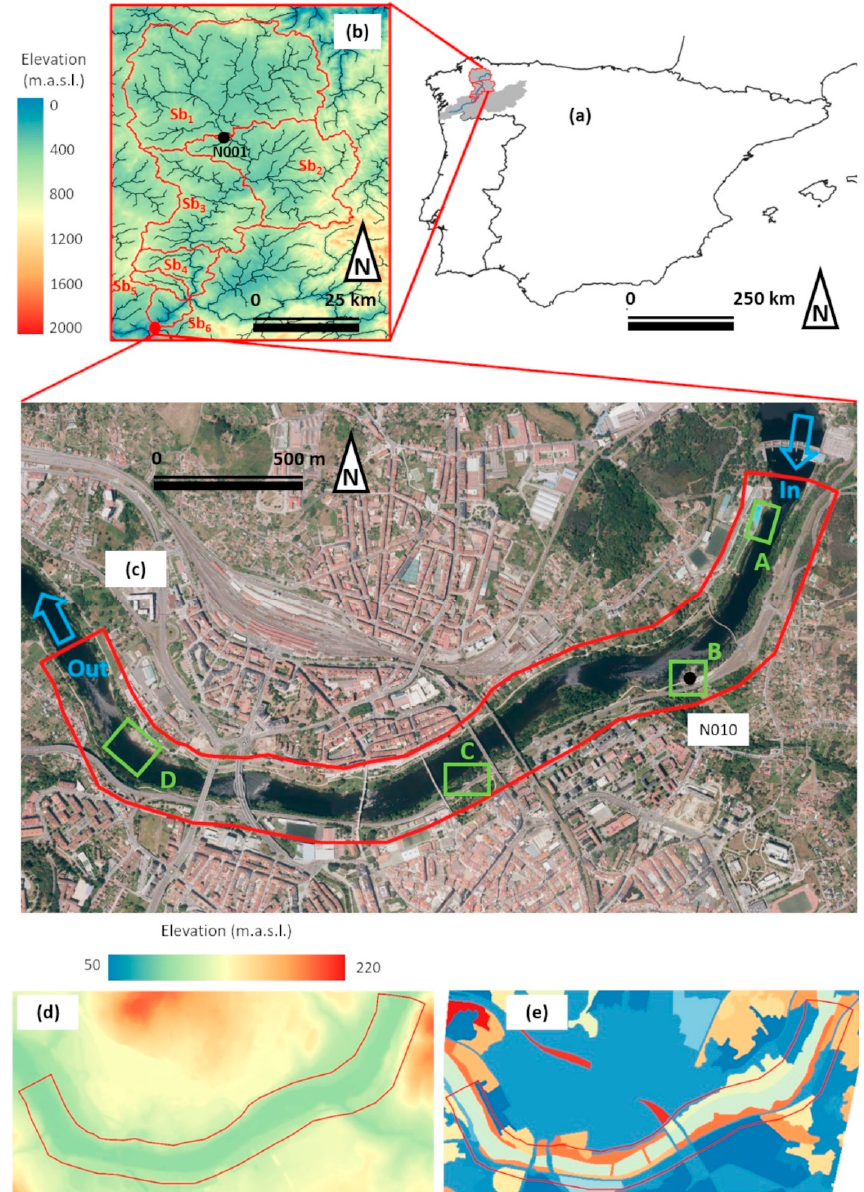
Figure 1. Area of study. ( a ) location of the entire catchment of the shared Portuguese–Spanish Miño River (shaded area) in the Iberian Peninsula and the riverbed (blue line); ( b ) subbasins (Sb1, Sb2, …, Sb6) of the domain; ( c ) area of study in Ourense (PNOA courtesy of © Instituto Geográfico Nacional). Area enclosed by the red line defines the domain of the hydraulic model. The inlet and outlet boundaries of the domain and the gauge stations N001 (Lugo) and N010 (Ourense) are also shown. Green rectangles define the control areas. Control area A: public sport facility; control area B: gauge station N010; control area C: public path; control area D: public thermal baths. The inlet (in blue arrow) and outlet (out blue arrow) boundaries are also depicted. ( d ) Topographic features and ( e ) land uses of the area under study in Ourense.